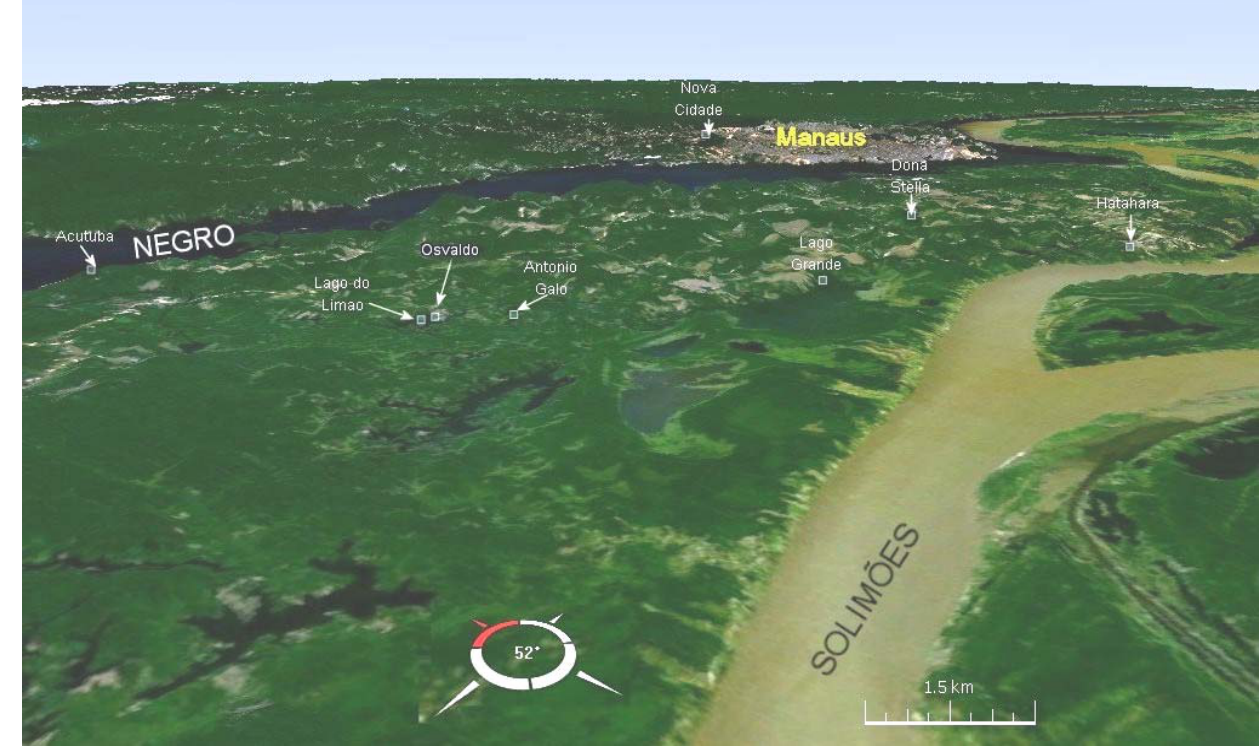
Figure 1. Some of the sites studied by the Central Amazon Project [43]. Note the diversity of geographical emplacements, which includes river bluffs near black and white water rivers, areas with flooded forest, and terra firme